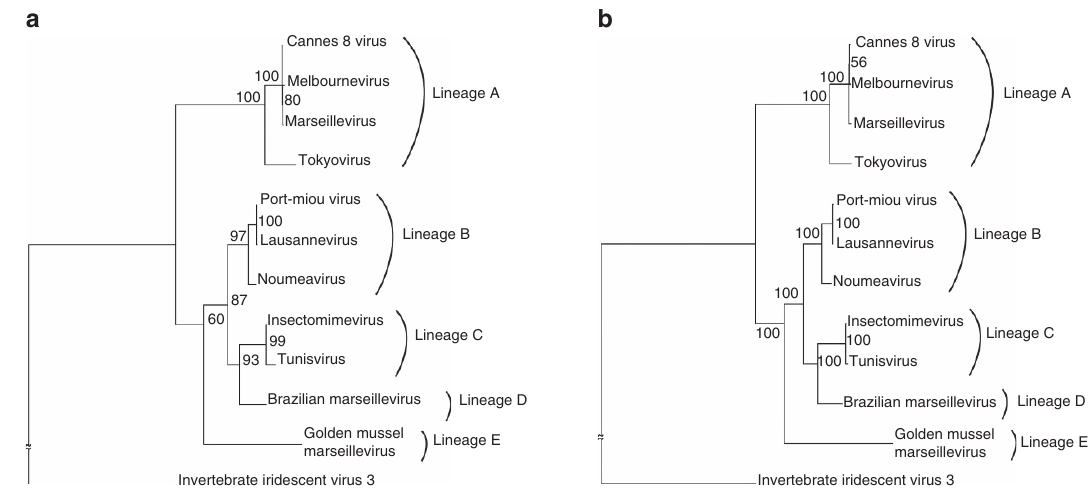
Figure 3 | Phylogenetic analyses of Marseilleviridae. ( a ) Maximum likelihood phylogenetic tree of the DNA polymerase of Marseilleviridae build using RaxML 80 . Invertebrate iridescent virus 3 DNA was used as the outgroup. Numbers at the nodes indicate per cent bootstrap values. ( b ) Maximum